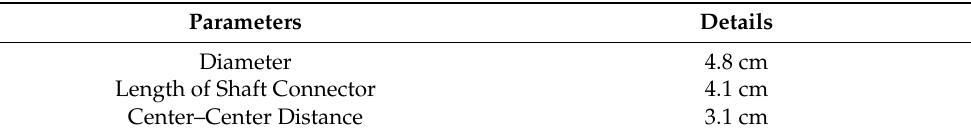
Table 3. Specifications of bearing wheels.